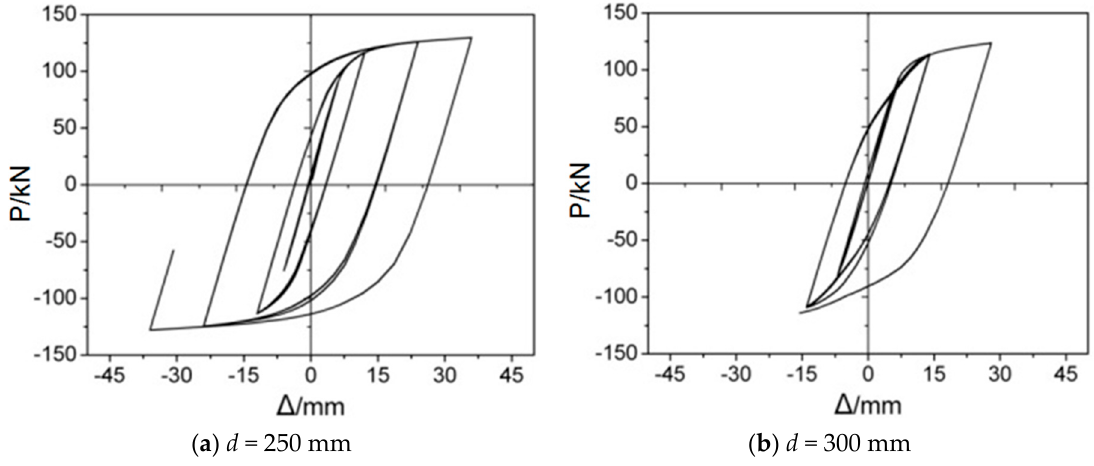
Figure 27. P– ∆ curves of two Figure 27. P– Δ curves of two joints.